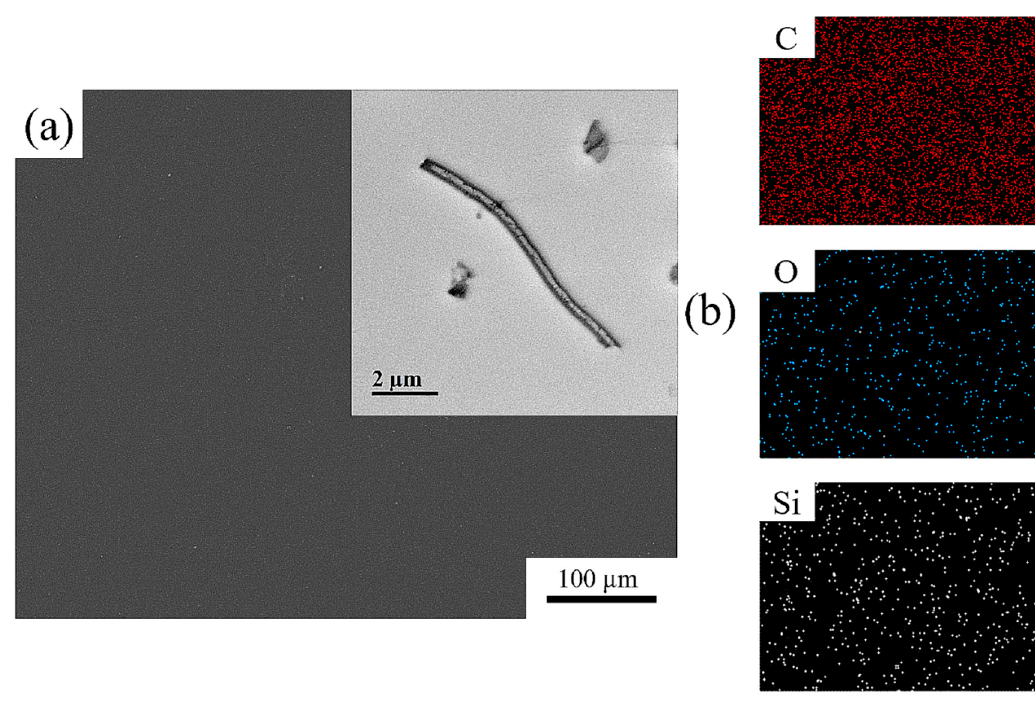
Figure 2. ( a ) FESEM and TEM (insert) images and ( b ) EDS images of carbon, oxygen and silicon of 5 wt% BPDA-BAPP/m-HSNF nanocomposites.